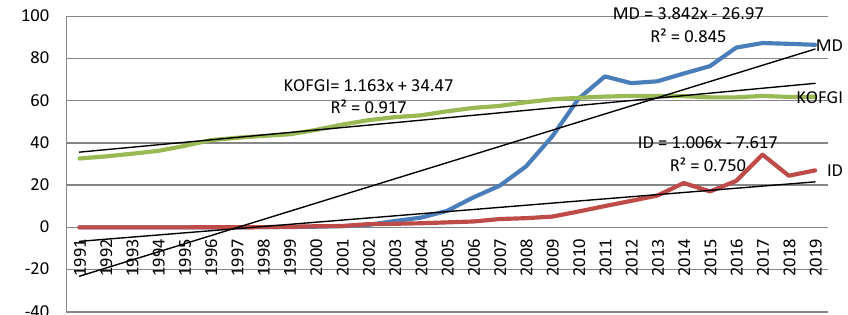
Fig. 1 Trends of mobile density, internet density, and KOF globalization index (Source: author’s illustration based on WDI and ETH Zurich KOF data)